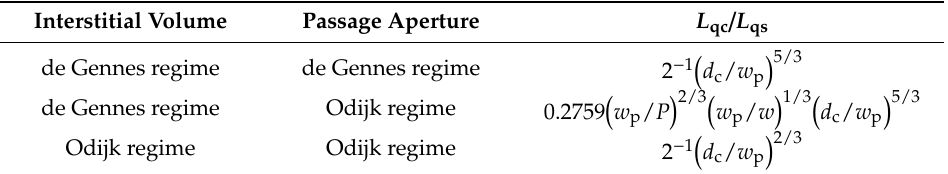
Table 2. Dependence of the ratio L qc / L qs of the chain length situated in interstitial volumes and passage apertures, L qc and L qs , respectively, on d c / w p ratio in the three possible combinations of confinement